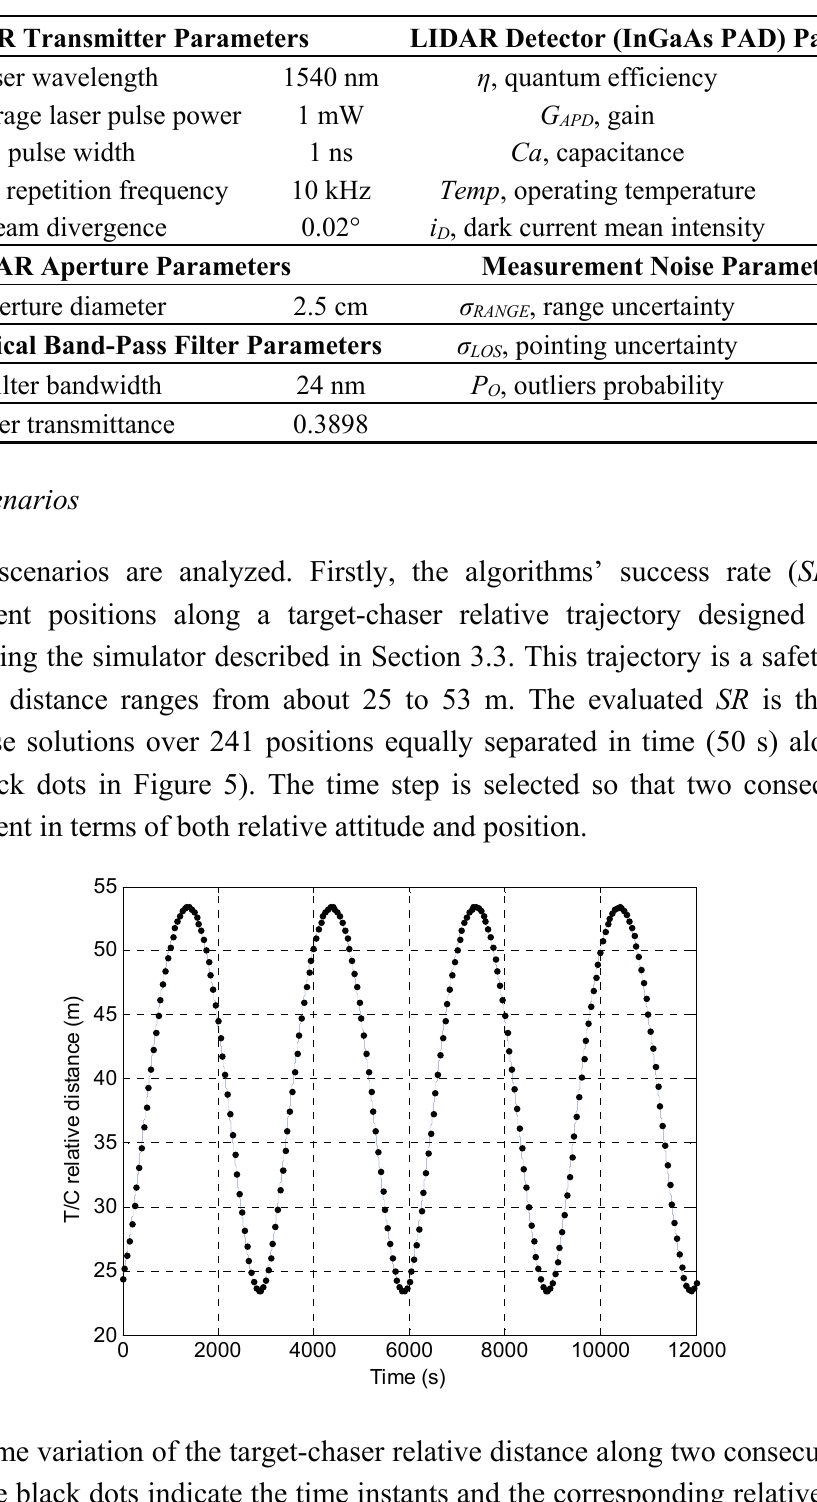
Table 1. LIDAR system parameters.